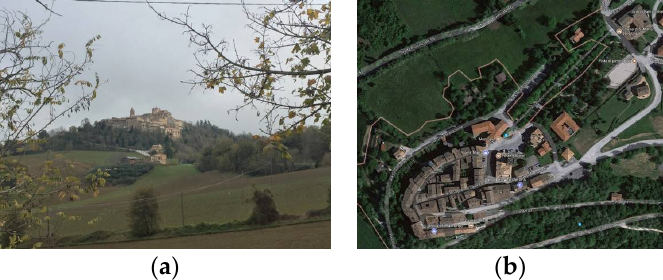
Figure 1. The village of Gualdo ( a ) is located on the top of a hill of the Marche region (November 2016, photo IP). ( b ) The historical downtown left, the ancient monastery now hospice right. In the middle the school building (Google